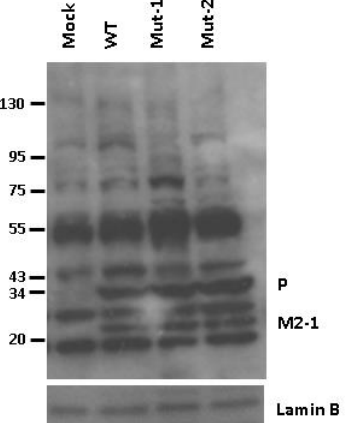
Figure 6. Nuclear presence of hMPV proteins. Cell infection was done as described in Figure 1. The nuclear presence of hMPV proteins was determined by Western blot using an antibody against hMPV. The membrane was stripped and reprobed using an antibody against Lamin B as an internal control for protein integrity and loading.